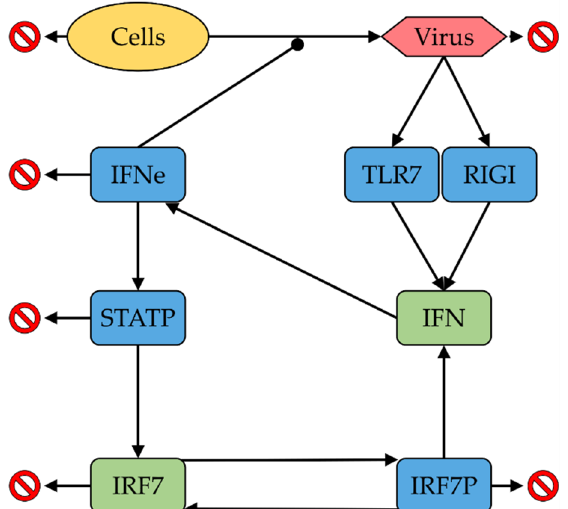
Figure 1. Schematic of intracellular immune signaling system. Crossed red circles represent decay or death, straight black arrows represent positive interactions and the circle-capped black arrow represents antagonism through Interferon Stimulated Genes (ISGs). Blue boxes are proteins (Environmental type-I Interferons (IFNe), Toll-Like Receptor 7 (TLR7), Retinoic Acid-Inducible Gene I (RIGI), phosphorylated Signal Transducer and Activator of Transcription (STATP) and Interferon Regulatory Factor 7 (IRF7P)). Green boxes are RNA species (Type-I Interferons (IFN) and Interferon Regulatory Factor 7 (IRF7)). The gold oval is the normalized Human Bronchial Epithelial Cell population. The red hexagon represents a normalized viral titer.